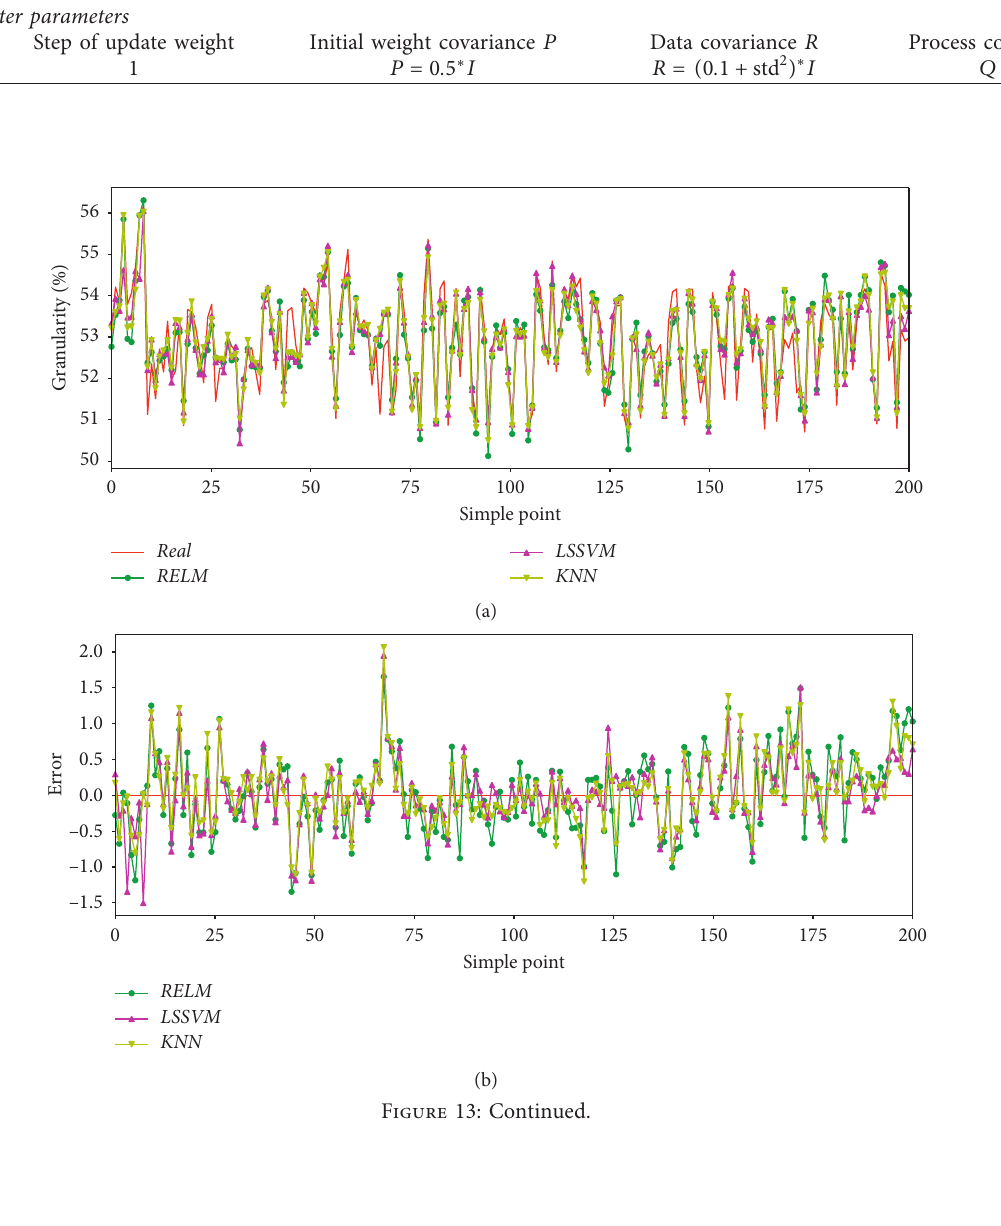
Table 9: The structural parameters of the KNN model and the hyperparameters of the Kalman filter method. (a) Neural network model structure parameters (b) Kalman filter